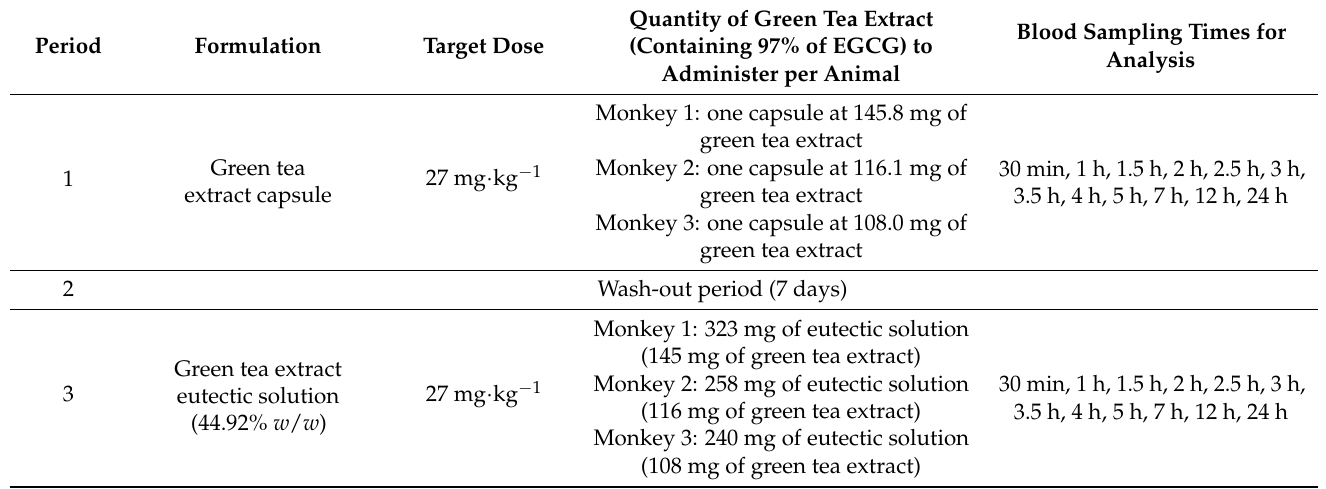
Table 2. Conditions of the bioavailability